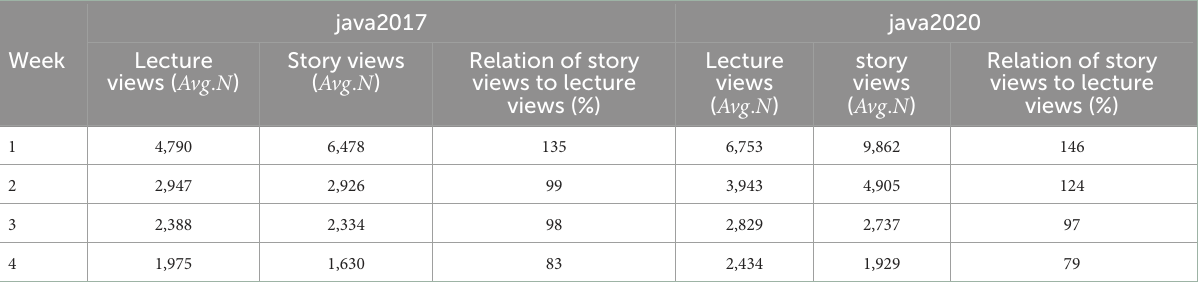
TABLE 3 Average number of video lecture views compared to story video views per course week in the java2017 and the java2020 course (Hagedorn et al.,